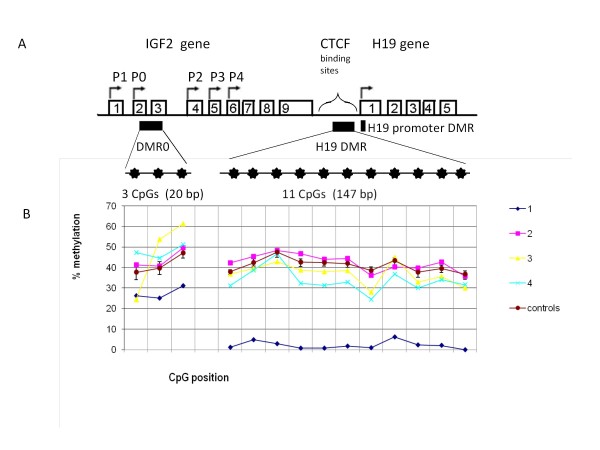
A Structural characteristics of the humanIGF2/ H19 locus with nine exons and five exons for IGF2 and H19 genes respectively. Transcription start site and promoters used are indicated by arrows. Regions of differentially methylated regions (DMRs) are shown with black bars. For each DMR, the number of CpGs analysed is indicated and their relative positions are represented by filled stars corresponding to the methylation site horizontal axis of Figure 1B. B Graph of methylation patterns of the IGF2/H19 locus (expressed as percentage for each CpG) for each case and mean with 95% confidence interval for the 95 control samples.